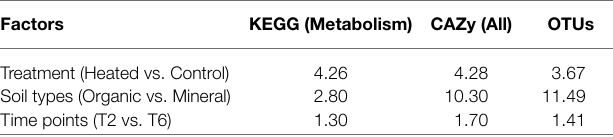
TABLE 2 | Effect size calculation – effect size estimation ( η 2 ) on transcripts annotated by KEGG and carbohydrate-active enzyme (CAZy) databases and phylum abundances annotated by MATAM.